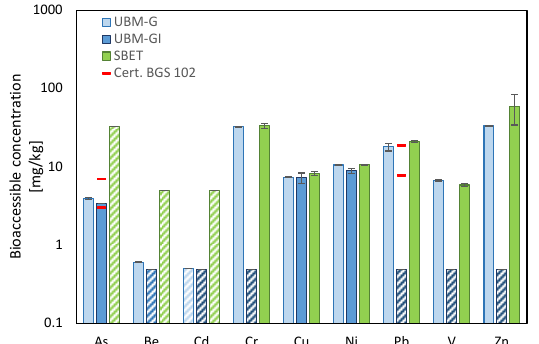
Figure 2. Bioaccessibile concentrations obtained applying the Unified Barge Method (UBM) (UBM-G: gastric phase; UBM-GI: gastro-intestinal phase) and Simple Bioaccessibility Extraction Test (SBET) to BGS102. The striped bars represent values below the limit of quantification. A 10-fold dilution of the extract for the SBET was applied.